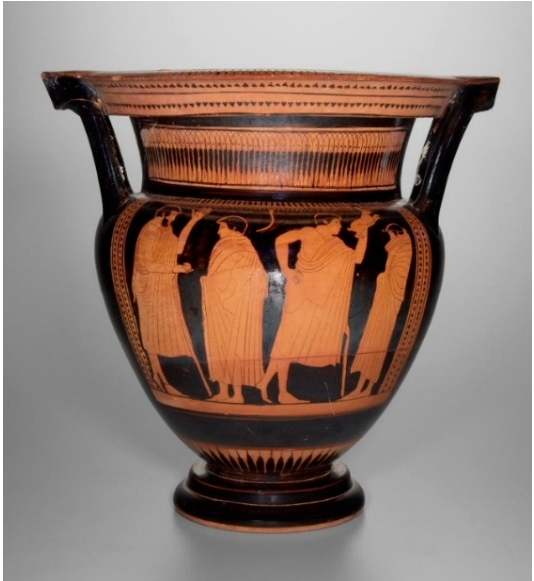
Figure 4. Obverse of a krater attributed to the Agrigento Painter. New Haven, Yale University Art Gallery 1933.175. Photo courtesy Yale University Art Gallery. https://artgallery.yale.edu/collections/objects/5658. In the public domain. 475-450 BCE.